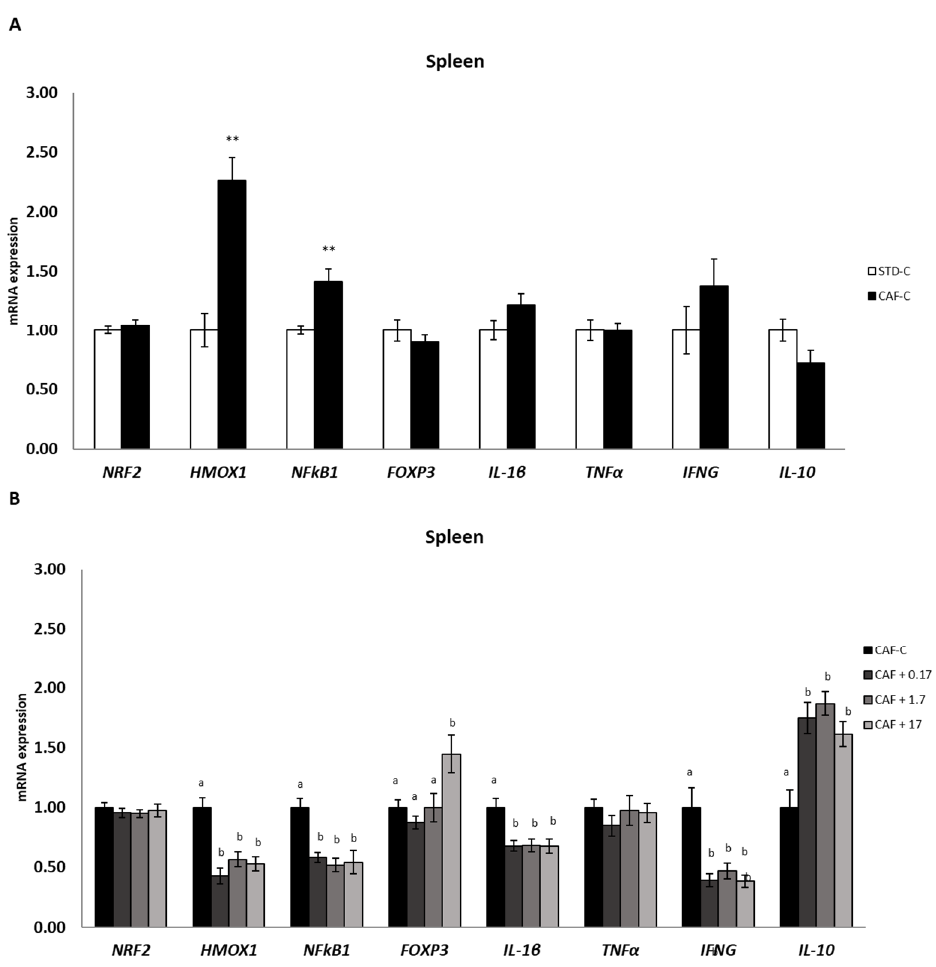
Figure 5. mRNA expression in the spleen. All values are means ± standard error of the mean (SEM). Differences between rats fed standard (STD) diet and supplemented with vehicle (STD-C, n = 8) and rats fed cafeteria (CAF) diet and supplemented with vehicle (CAF-C, n = 8) ( A ) STD-C were assessed by using Student’s t parametric test ( t test) for independent samples: **, significantly different compared to the STD-C group ( p < 0.01). Differences among CAF-C rats, rats fed CAF diet and supplemented with 0.17 mg kg − 1 body weight (bw) per day of TetraSOD ® (CAF + 0.17, n = 8), rats fed CAF diet and supplemented with 1.7 mg kg − 1 bw of TetraSOD ® (CAF + 1.7, n = 8) and rats fed CAF diet and supplemented with 17 mg kg − 1 bw of TetraSOD ® (CAF + 17, n = 8) ( B ) were evaluated by the ANCOVA test, using the percentage of body fat in the 8th week (before treatment) as a covariable: ab letters indicate statistically significant differences among the CAF groups ( p < 0.05). FOXP3, forkhead box P3; HMOX1, heme oxygenase 1; IFNG, interferon gamma; IL-1 β ; interleukin 1 beta; IL-10; interleukin 10; NF κ B1, nuclear factor kappa B subunit 1; NRF2, nuclear factor, erythroid 2-like 2; TNF α , tumour necrosis factor